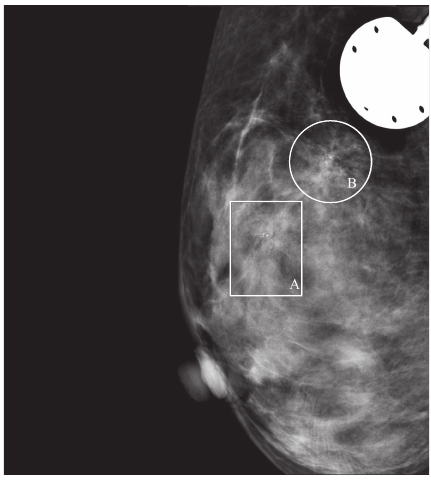
Figure 1: Mammographic image of the breast showing 2 groupings (A and B) of microcalcifications in the upper medial aspect of the right